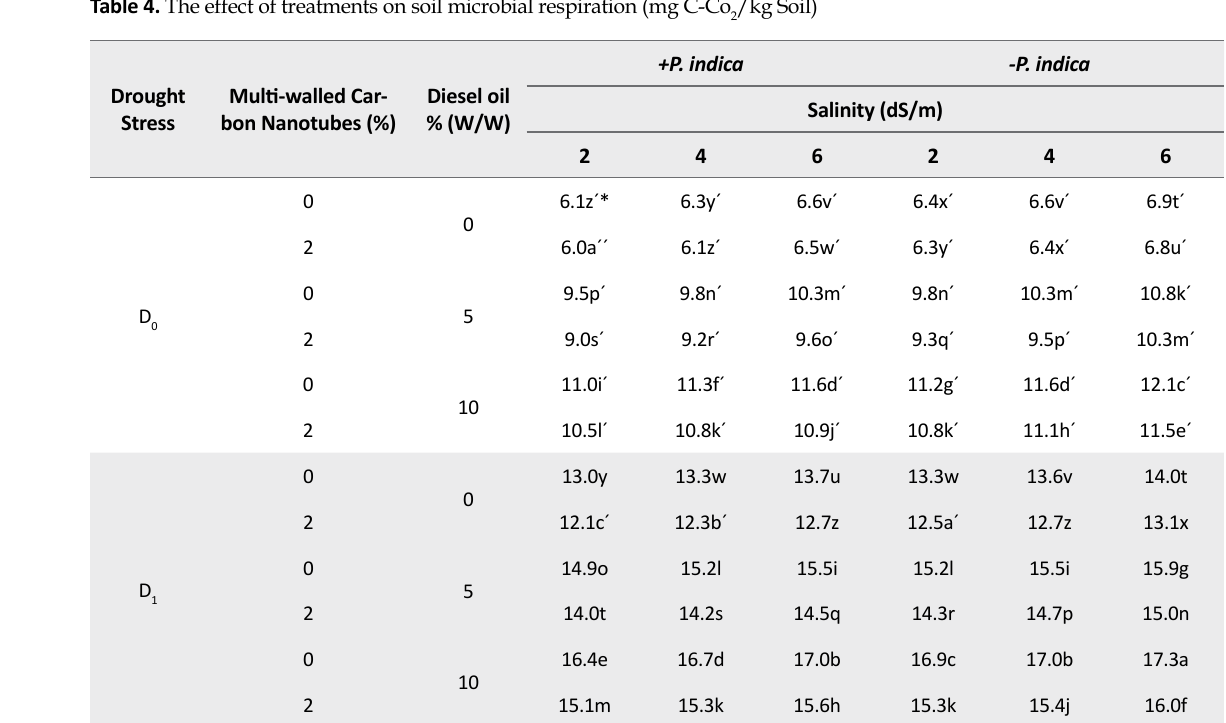
Table 4. The effect of treatments on soil microbial respiration (mg C-Co